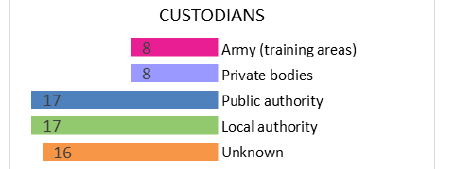
Figure 2. Sites distribution according to the type of custodians